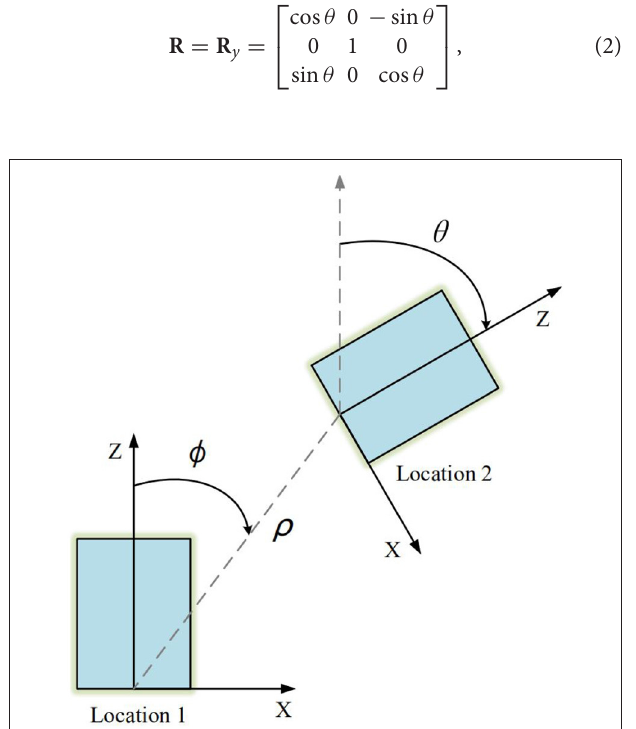
FIGURE 1 | Planar motion from Location 1 to 2 in top-view. The relative pose can be described by θ and φ , where θ represents the yaw of the vehicle and φ represents the direction of translation. ρ denotes distance between two